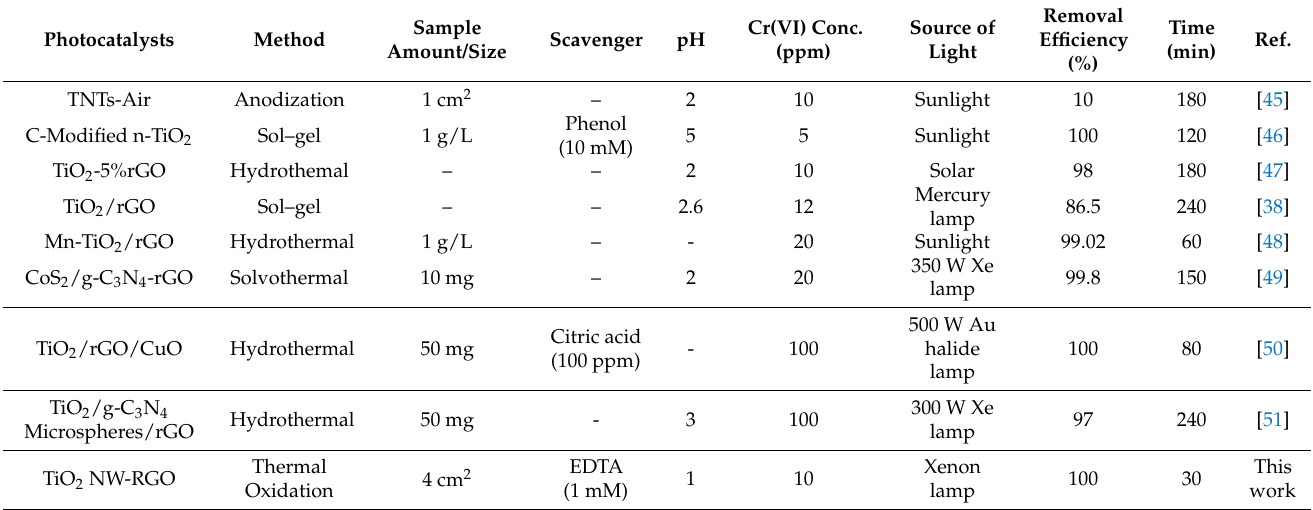
Table 1. Comparison of obtained Cr(VI) reduction efficiency with recent studies under UV–Vis light irradiation (RGO = reduced graphene oxide; C =